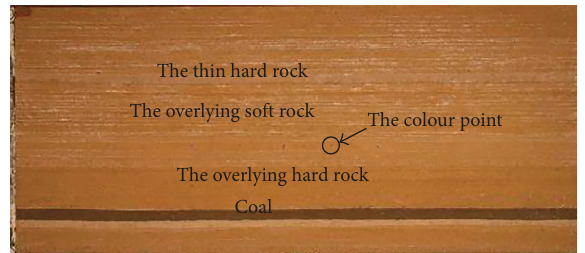
Figure 1: The manufactured similar material simulation